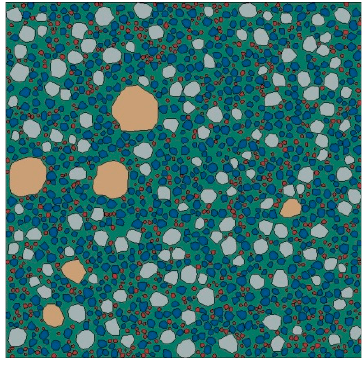
Figure 5. 2D RPA model.